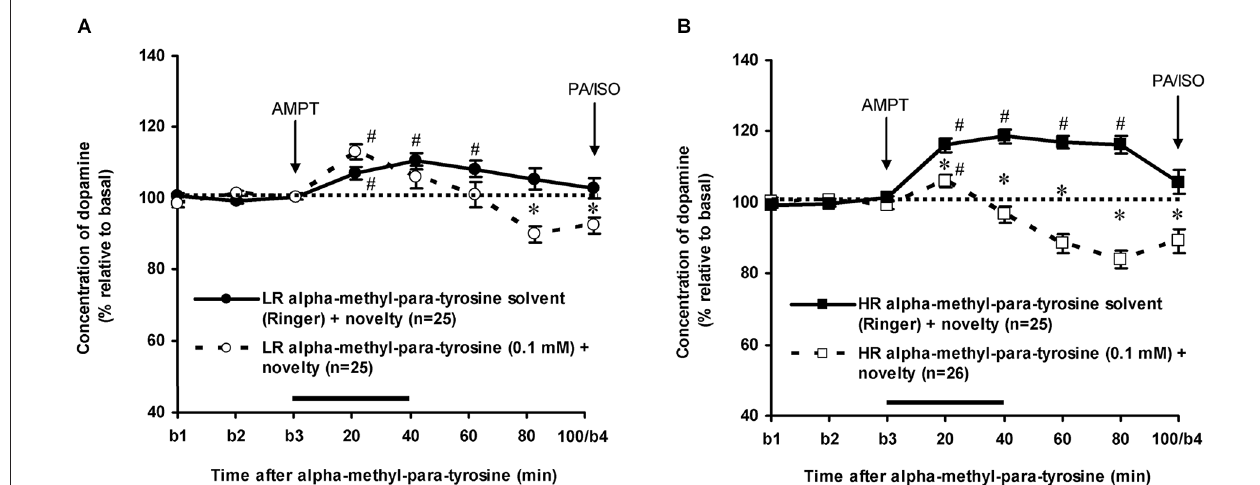
of the control animals were returned to baseline when PA and ISO were infused, whereas the DA levels in AMPT-treated animals were still reduced. Data are expressed as mean percentage ± SEM. The solid horizontal line represents the infusion time of AMPT. # Significant DA increase after novelty (DA levels were compared to baseline levels using one sample t -tests). * Significant DA decrease after AMPT (DA levels of AMPT-treated rats were compared to DA levels of control (Ringer) animals using Student’s t -tests).